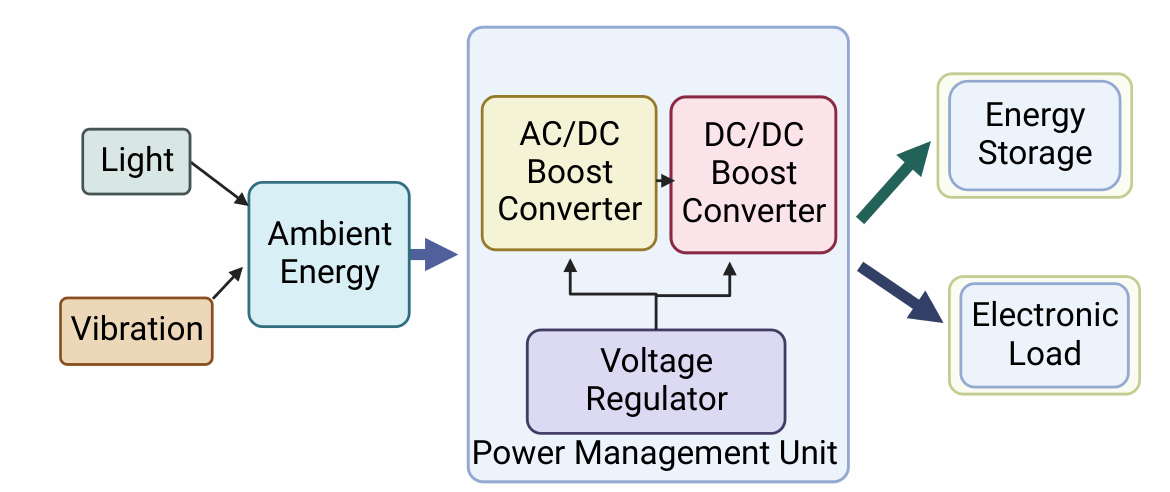
Figure 16. Energy Harvesting System. Table 7. Summary of power consumption of several wearable and medical devices. Device Power Requirement